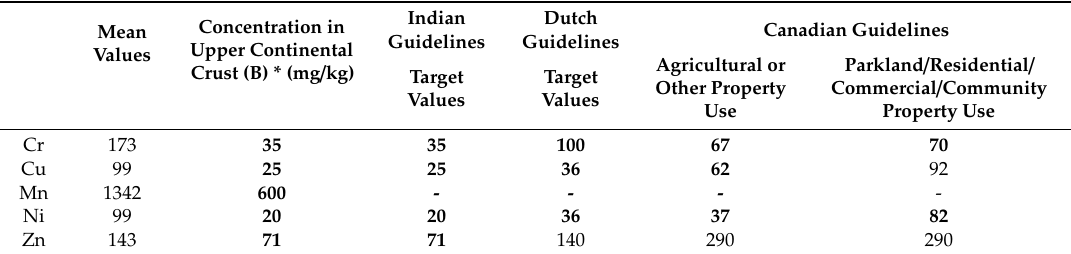
Table 6. Mean concentration of heavy metals in the studied site; composition of the upper continental crust and permissible limits (in mg kg − 1 ) as per Indian, Dutch, and Canadian soil.